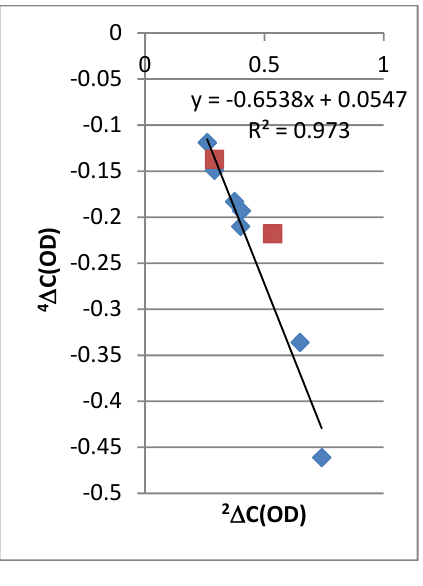
Figure 2. Plot of four-bond deuterium isotope effects on 13 C chemical shifts vs. two-bond deuterium isotope effects on 13 C chemical shifts. Red squares are data for HBQ and 4-nitro-HBQ in DMF- d 7